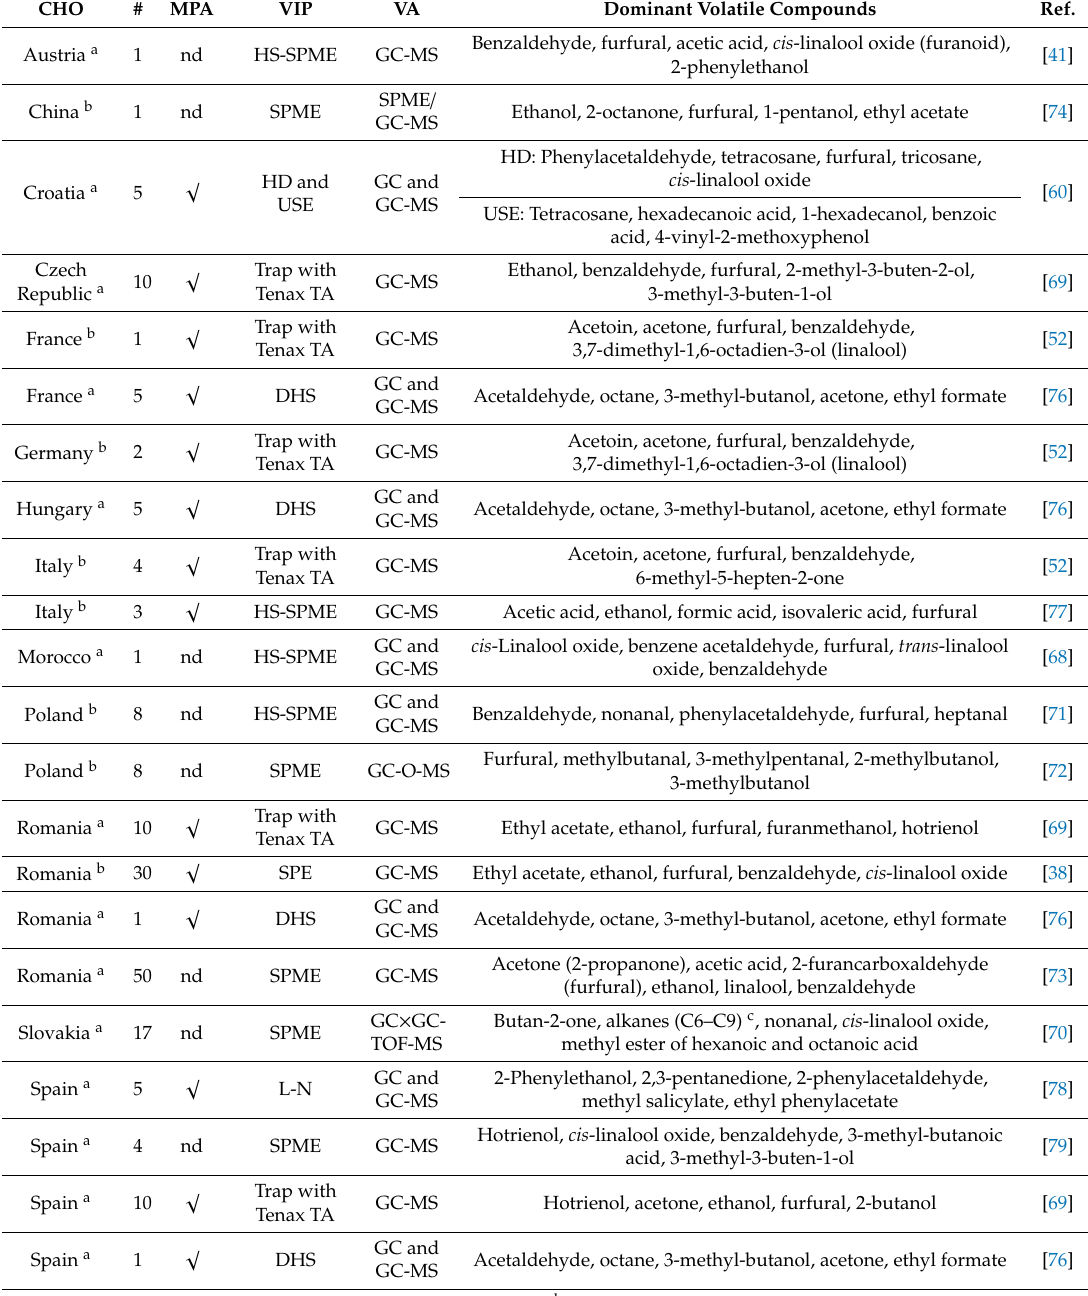
Table 2. Acacia honey’s main volatiles, with reference to the country of origin, number of samples, isolation and analysis procedures and five main volatile components. Unless otherwise specified, the honeybee type was A. mellifera .